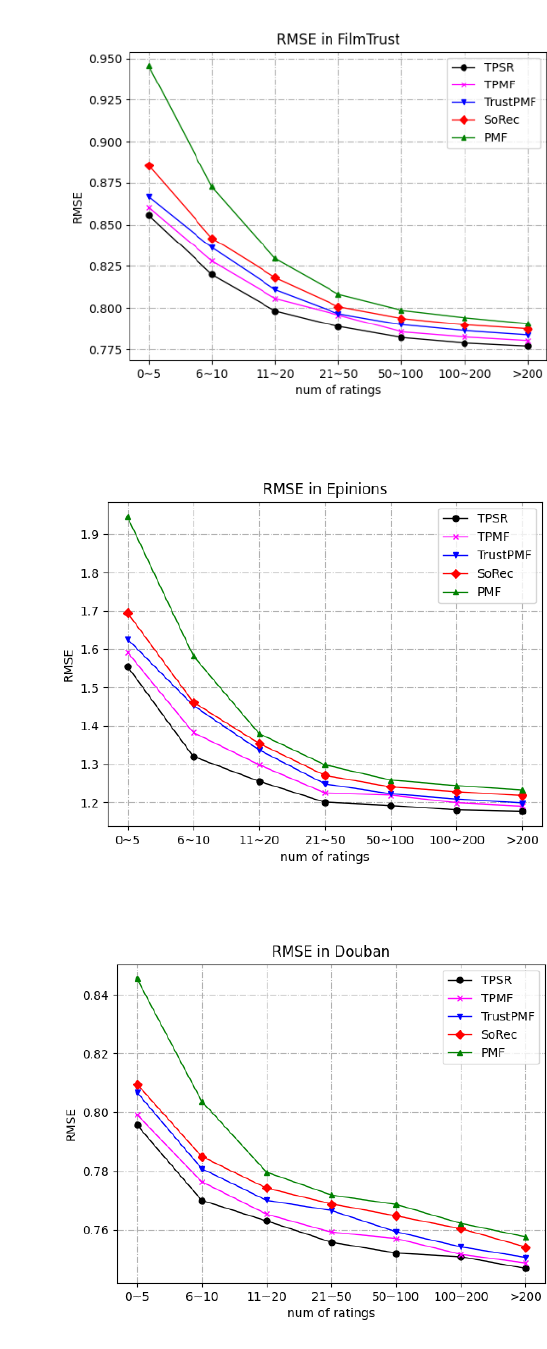
Figure 8. User grouping and grouping experiment results.